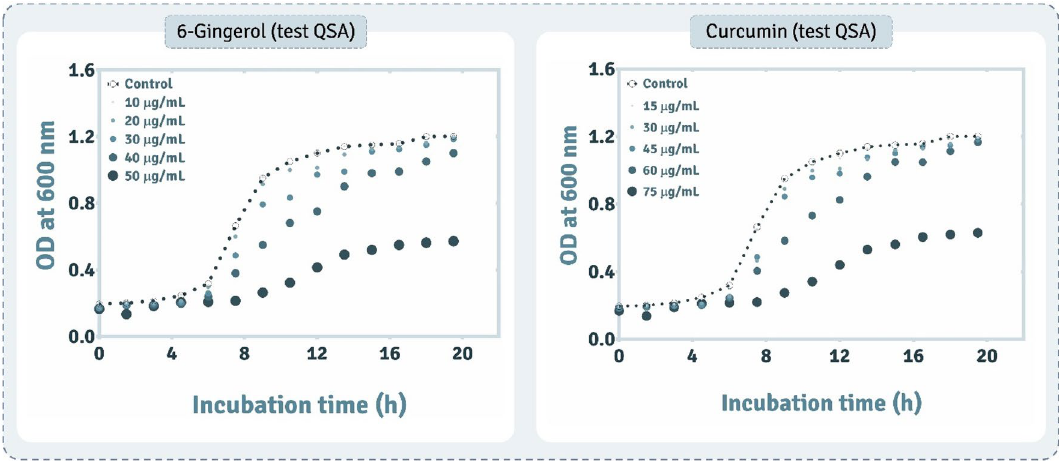
Figure 4. Assessing the influence on growth of P. aeruginosa in presence of varying concentrations of ( a ) 6-Gingerol and ( b )